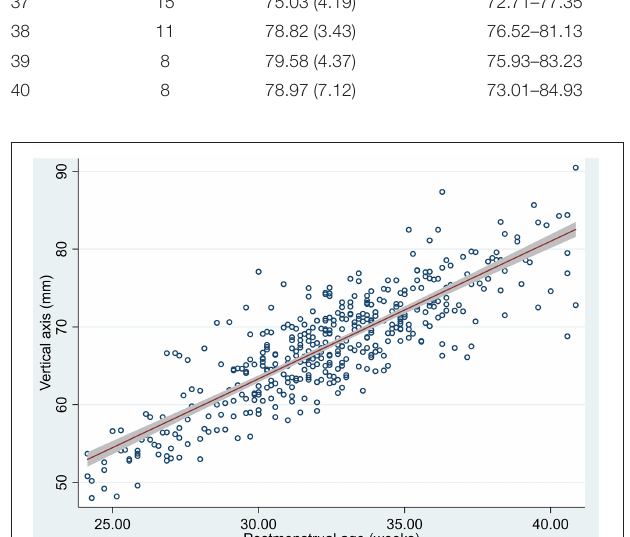
detailed description of the estimated parameters can be seen